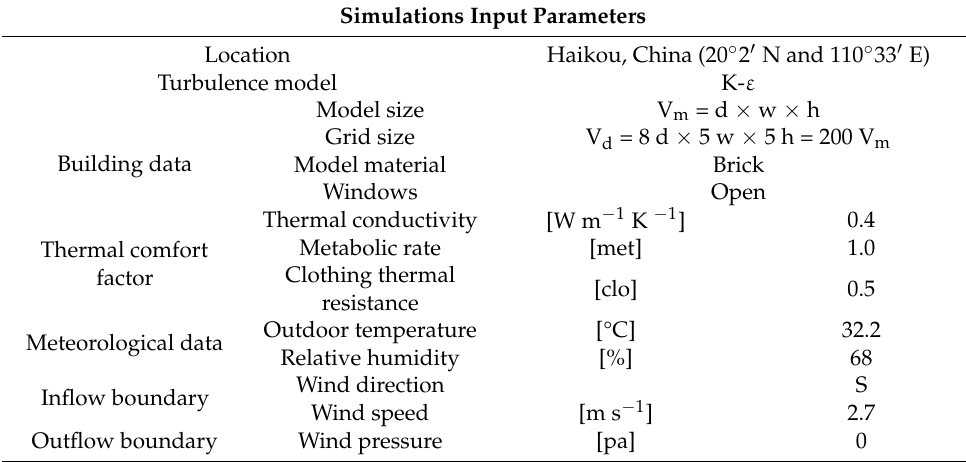
Table 1. Simulation boundary